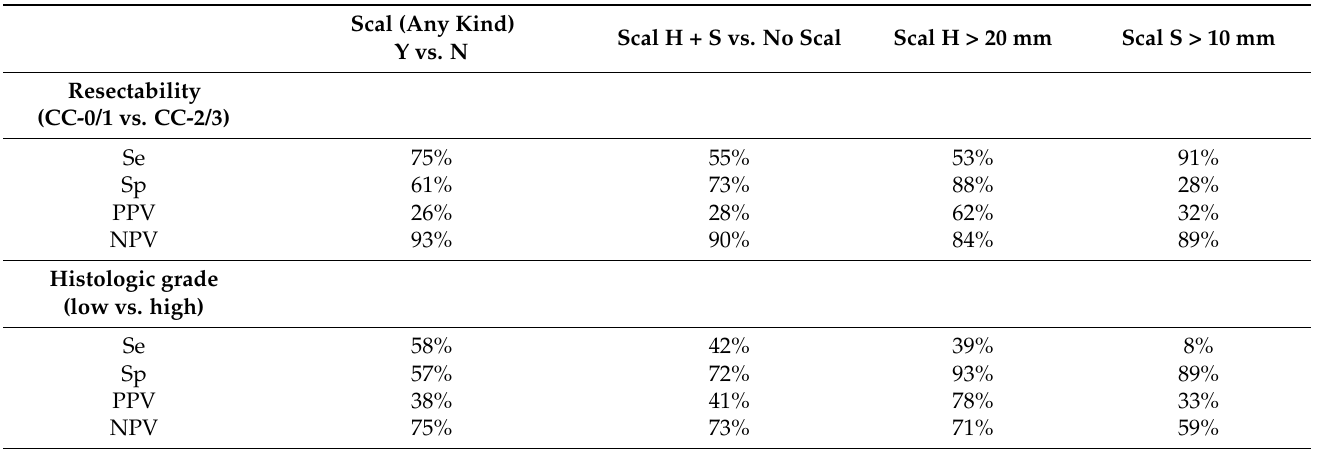
Table 2. Contingency table assessing scalloping value for prediction of resectability and histo- logic